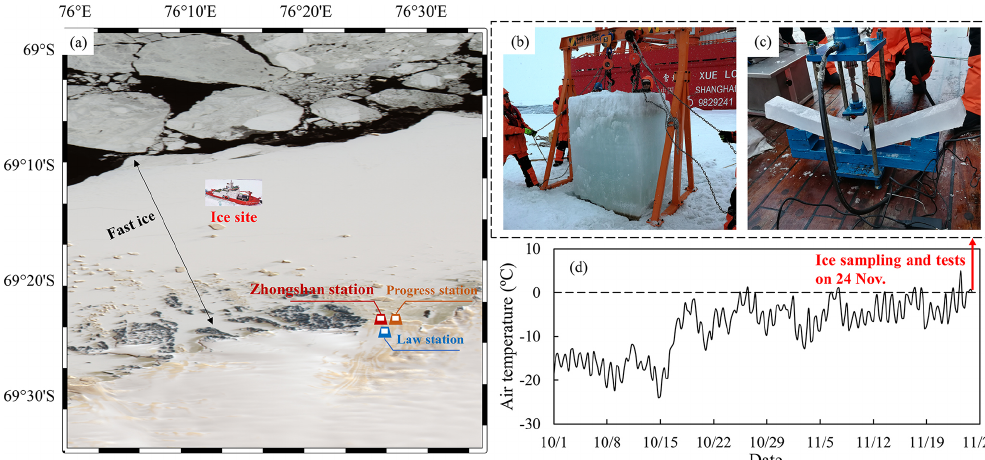
Figure 1. (a) Maps of the ice sampling site (69.2 ◦ S, 76.3 ◦ E), (b) ice block extracted for measurements, (c) bending tests performed on ship deck, and (d) air temperature from 1 October to 24 November 2019 at the Zhongshan station. The background in (a) is the ice image on 23 November 2019 derived from the HY-1C satellite (https://osdds.nsoas.org.cn/, last access: 20 December 2020).